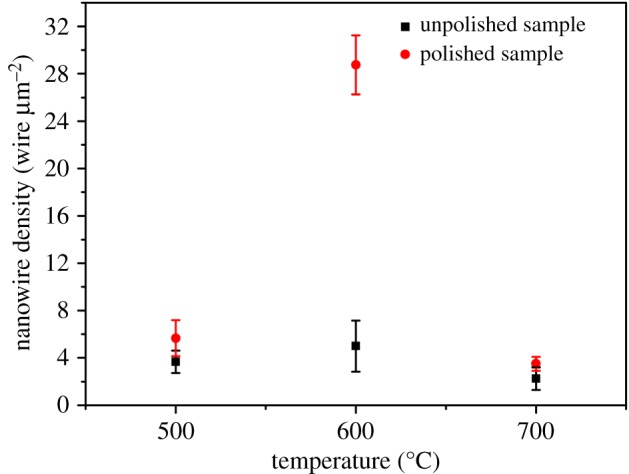
Statistical variation of density of the Fe2O3 nanowires obtained at different experimental conditions.